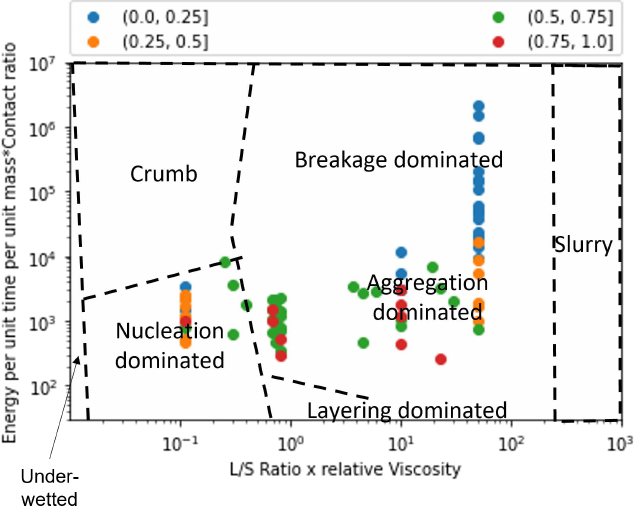
Figure 9. The regime map developed with proposed boundaries and each point colored according fill level within the